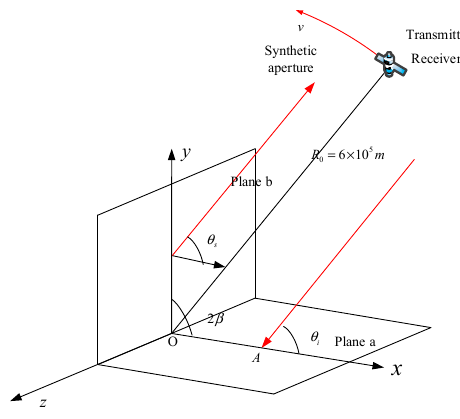
Figure 18. Sketch map of the SAR imaging simulation. Table 2. System parameters of the SAR simulation.